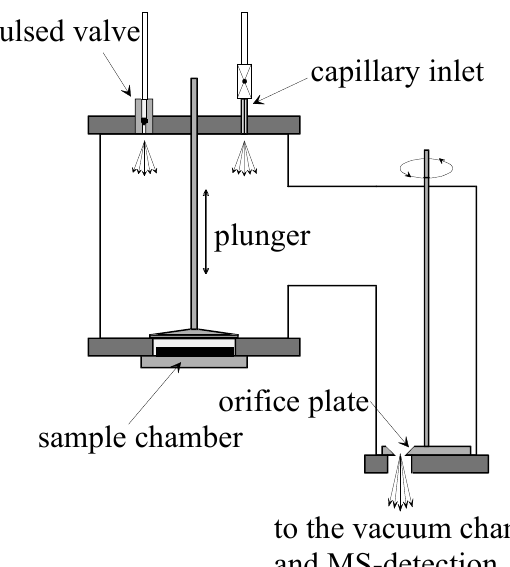
Fig. 3. Schematic of a Knudsen cell for the investigation of hetero- geneous reactions using either continuous flow or pulsed gas admis- sion. The rotatable orifice plate can put up to four molecular-beam forming orifices into line of sight with the ionizer of the mass spec- trometric (MS) detector (from Caloz et al.,